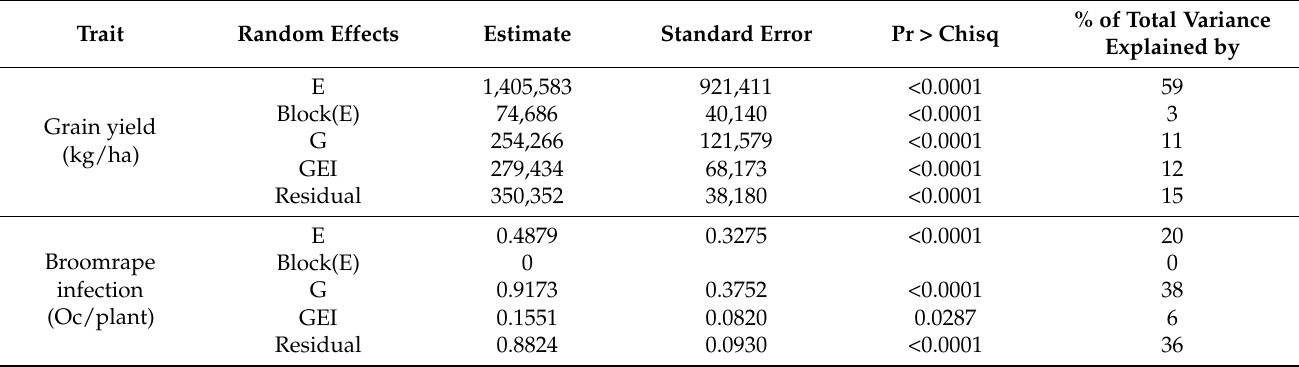
Table 4. Pooled ANOVA and estimated variance components of grain yield (kg/ha) and broomrape infection (Oc/plant) in field trials, consisting of 15 genotypes (G) grown in six environments (E).